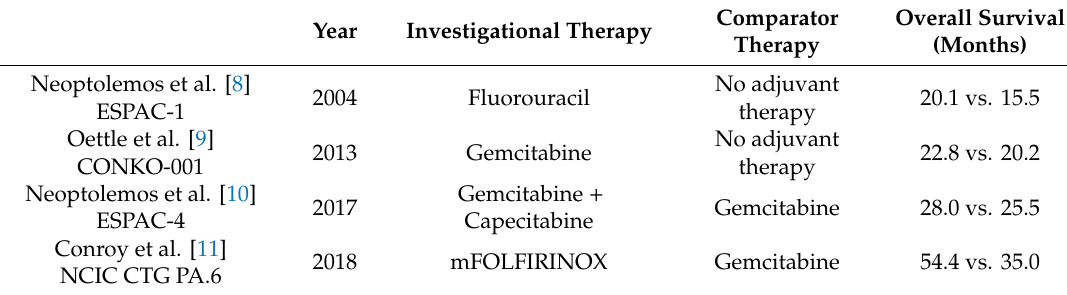
Table 2. Landmark clinical trials leading to the current empiric adjuvant chemotherapy regimens for resected PDAC. mFOLFIRINOX, modified